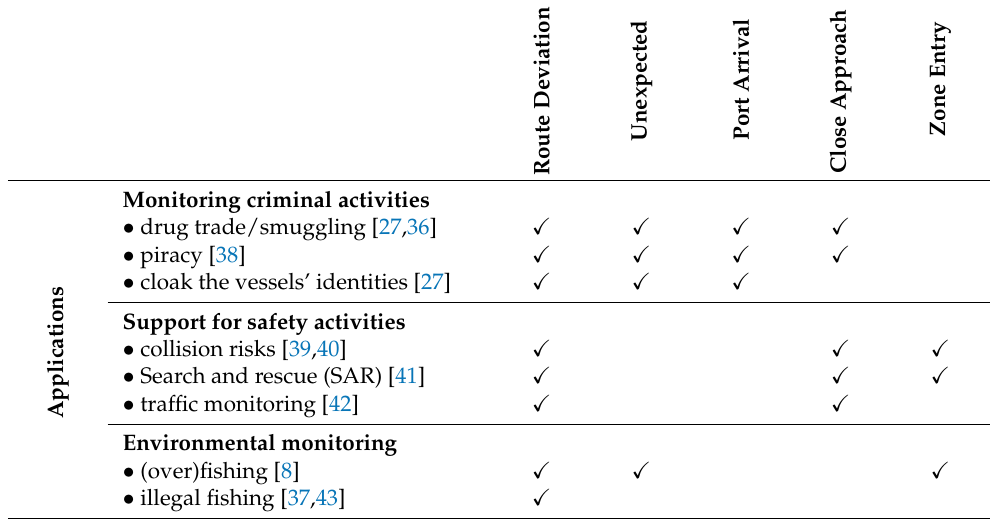
Table 2. Use cases supported by AIS anomaly detection methods presented in Figure2. References given in the Applications column address the individual use